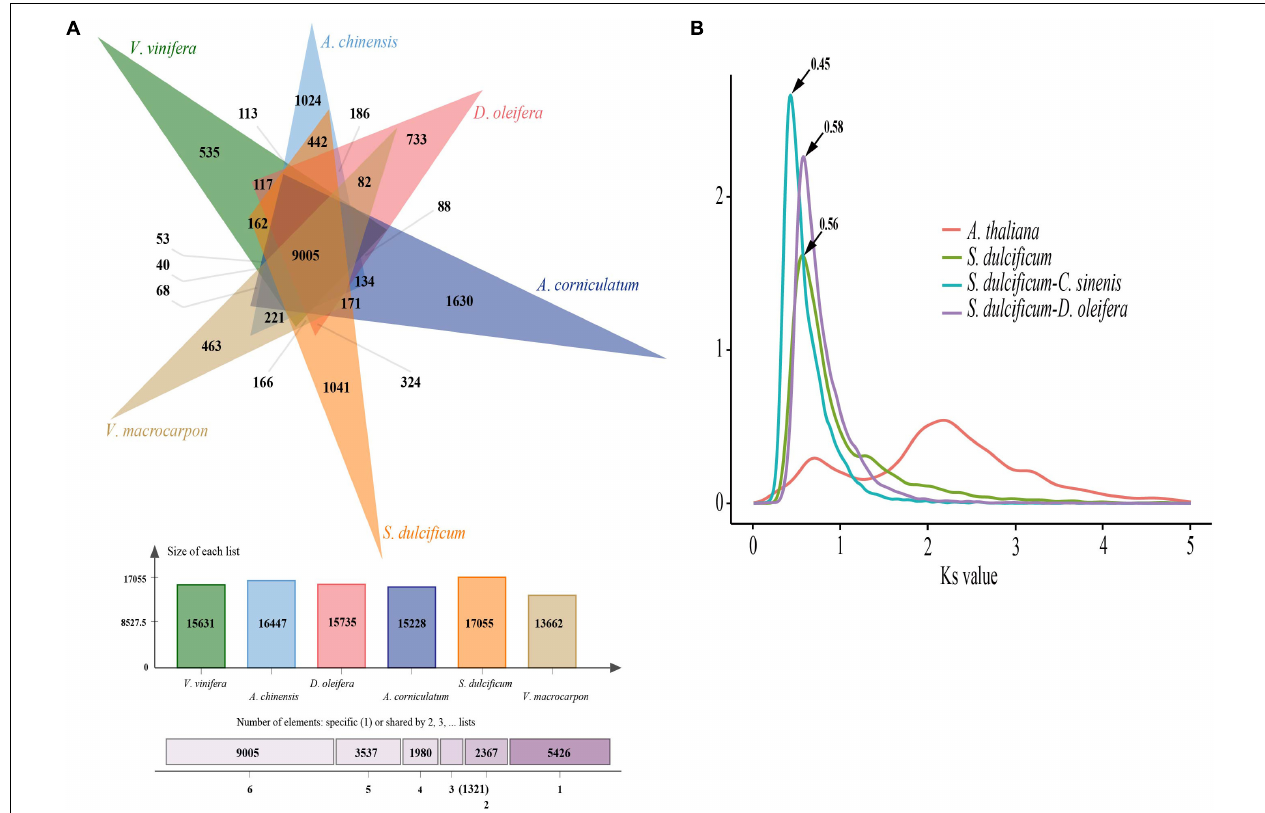
FIGURE 3 | Gene family and WGD analysis of S. dulcificum . (A) Gene family distributions between S. dulcificum , V. vinifera , A. chinensis , D. oleifera , V. macrocarpon , and A. corniculatum . (B) Synonymous substitution rate (Ks) distributions of paralogs and orthologs of A. thaliana , S. dulcificum , C. sinensis , and D. oleifera .